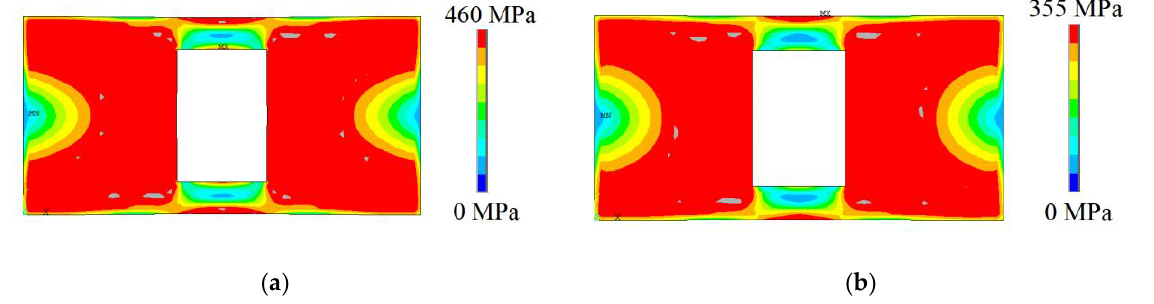
Figure 15: The von Mises stress distribution for the plate with rectangular hole made of steels: ( a ) AISI 4130 steel and ( b ) AH-36 steel.